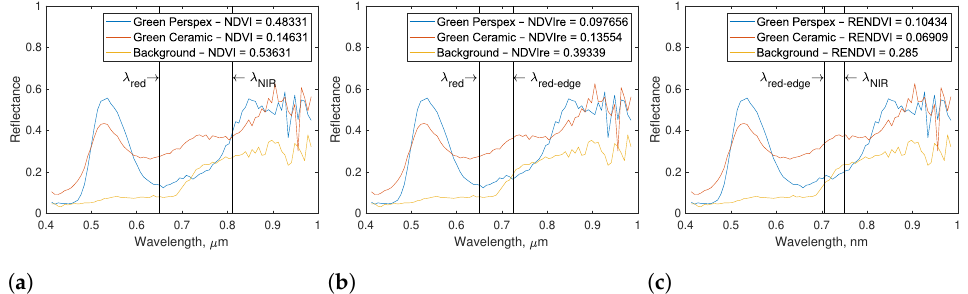
Figure 4. VI ratio of each of the three test spectra ( a ) NDVI ratio and band locations. ( b ) NDVI re ratio and band locations. ( c ) RENDVI ratio and band locations. Two of the targets from Figure 3a, green perspex (circled in blue) and green ceramic (circled in orange) were investigated for separation from the background when using VI- based spatial DR. Each of the three VIs investigated produce a ratio between the intensity of a pixel at two bands, the two targets produced VI values shown in Table 2. Table 2. Vegetation index ratios obtained for background and targets. Vegetation